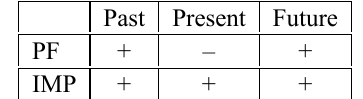
Table 1: Russian Aspect and